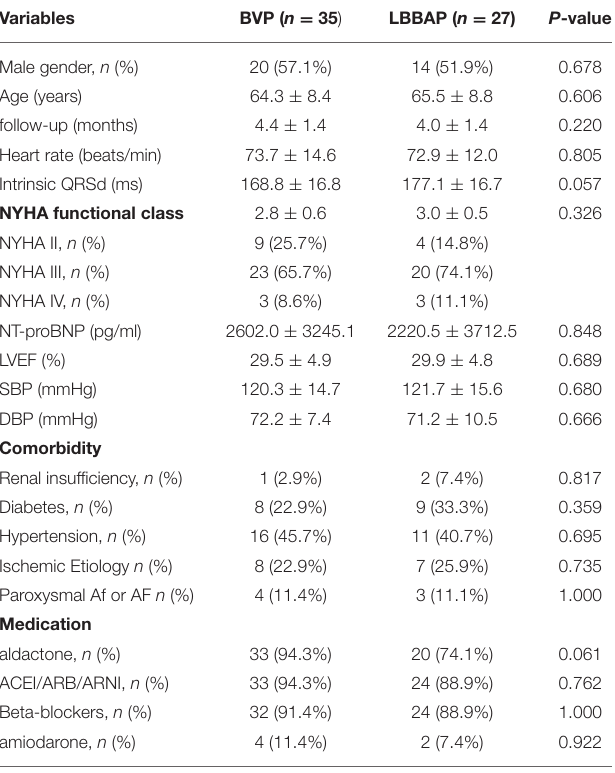
TABLE 1 | Baseline characteristics of the patients. TABLE 2 | Echocardiographic data in the LBBAP group at baseline and